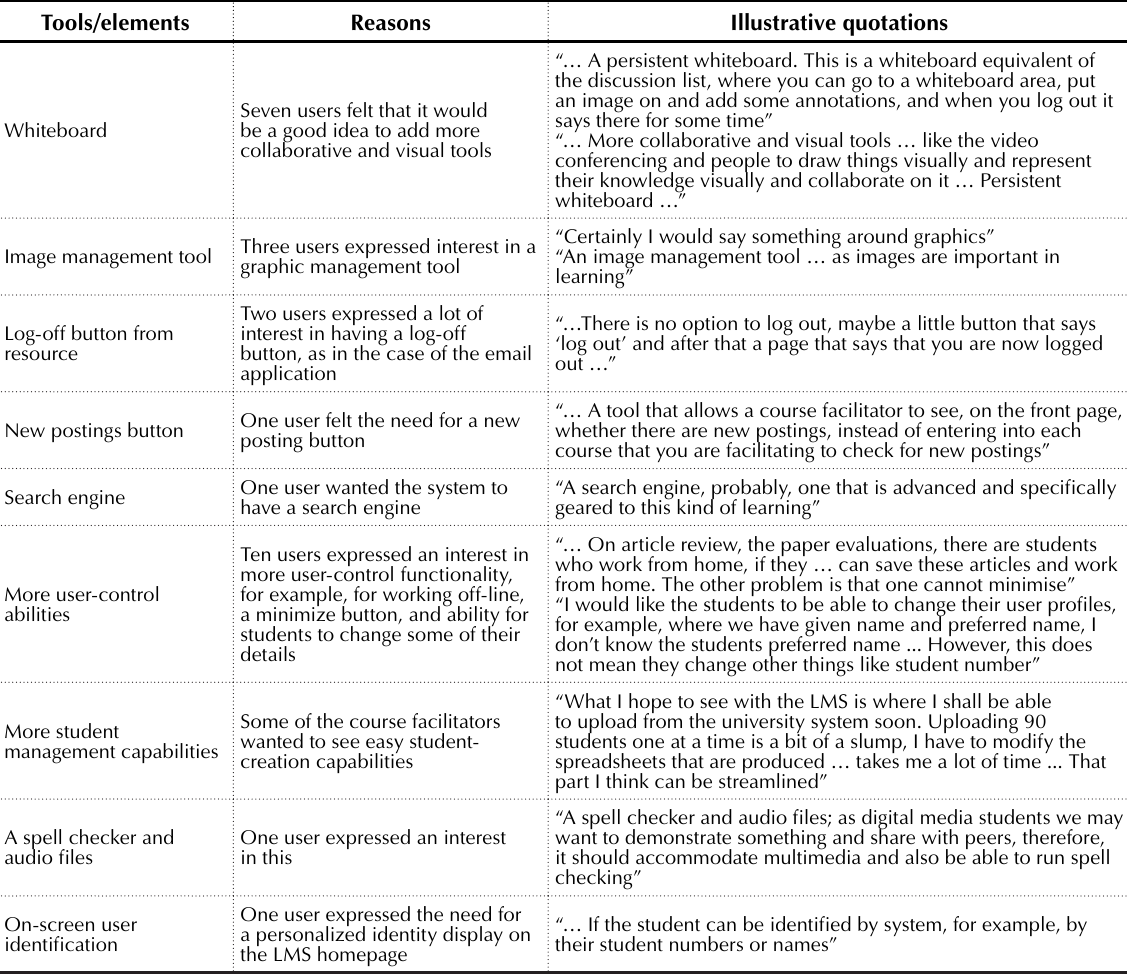
Table 6. Various tools and elements that users suggested should be added